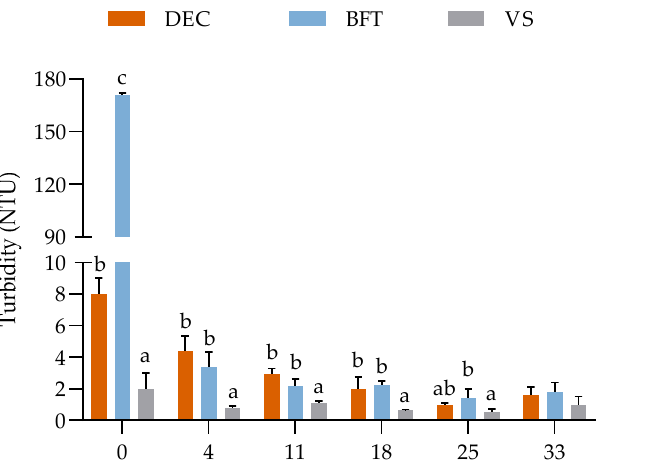
Figure 2. Weekly turbidity values in the DEC (with 30 mg L − 1 of TSS), BFT (with 400 mg L − 1 of TSS), and vs. (with von Stosch enrichment solution at a concentration of 10 mL L − 1 ) treatment groups during the 35 days of the experimental period. a, b, c = Different letters on the same day represent a significant difference ( p ≤ 0.05) between the treatments after one-way ANOVA with Tukey’s post-hoc test.